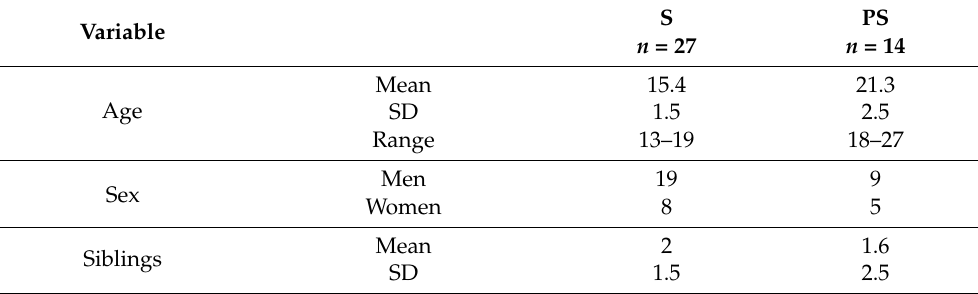
Table 1. Ego characteristics of the S and PS